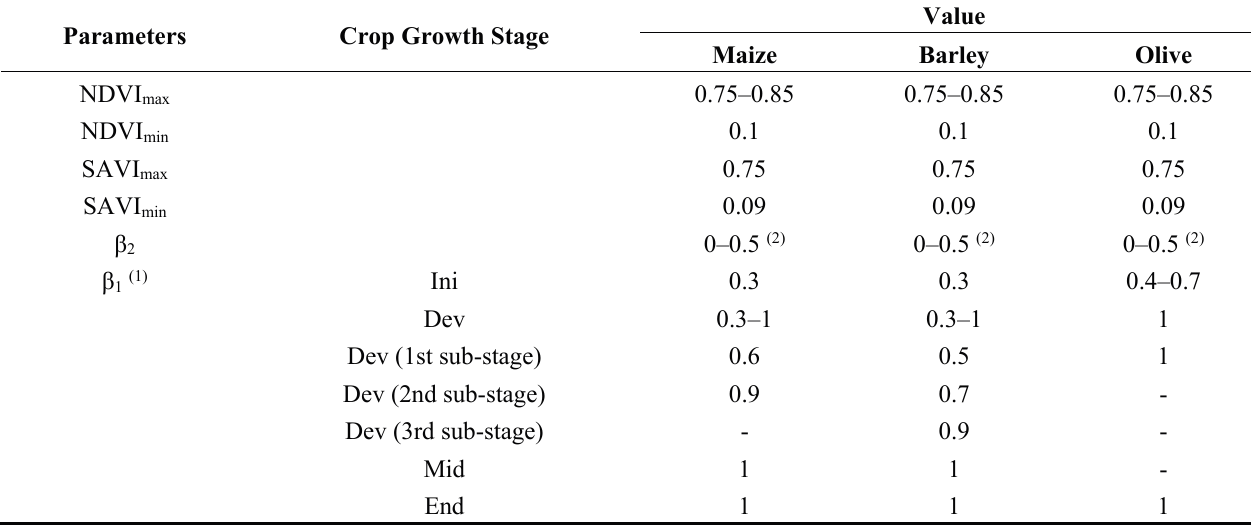
Table 4. Values of parameters considered in the estimation of fraction of ground cover from vegetation